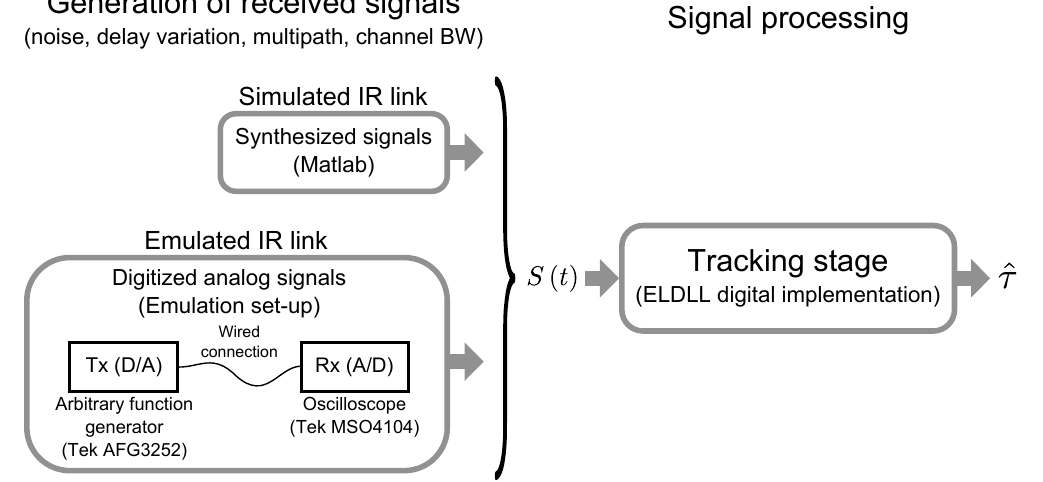
Diagram of the system validation procedure: Received signals generation (simulated and emulated IR link) and ELDLL digital implementation.